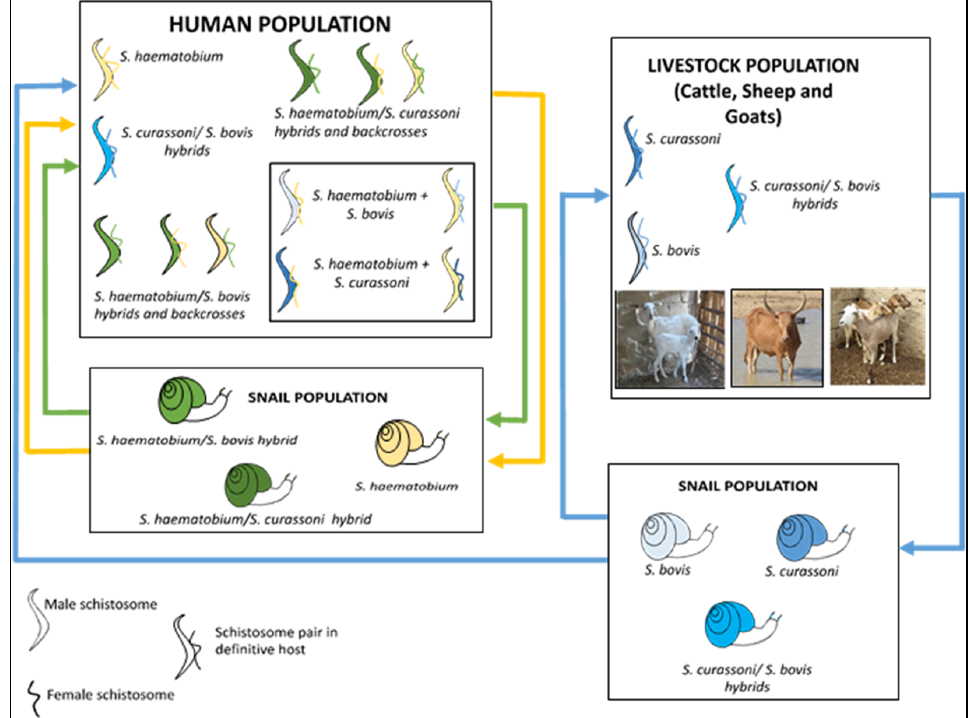
Figure 2. Zoonotic hybrid schistosome system proposed to occur in West Africa, including Nigeria [34]. Human schistosome species are shown as yellow, animal schistosome species are shown as blue, and hybrids between animal and human schistosome species are shown as green, with infected snails also represented with corresponding colours.